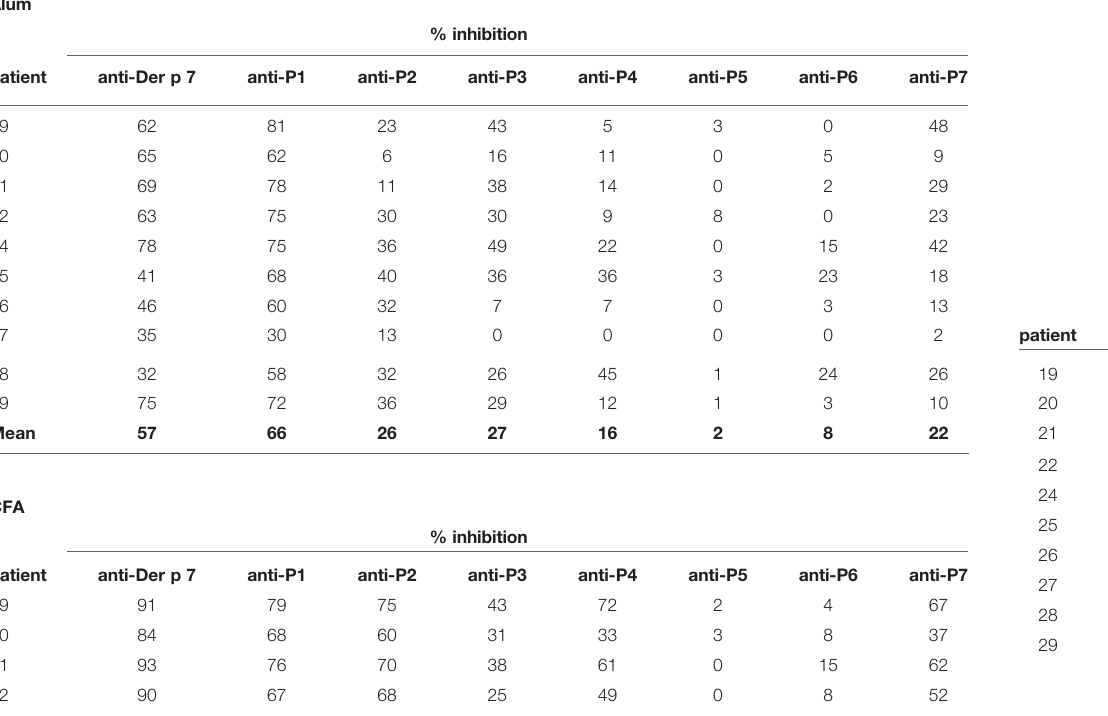
TABLE 1 | Inhibition of patients` IgE binding to Der p 7 by sera against Der p 7